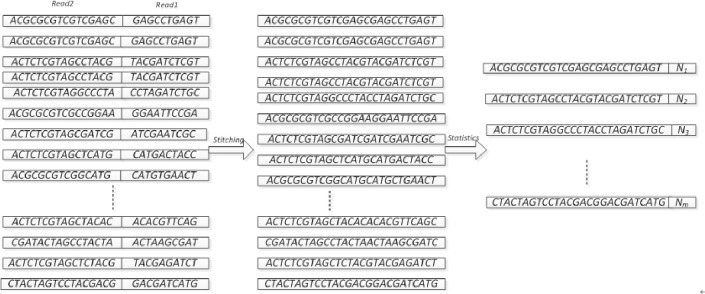
Sequencing sequence processing.